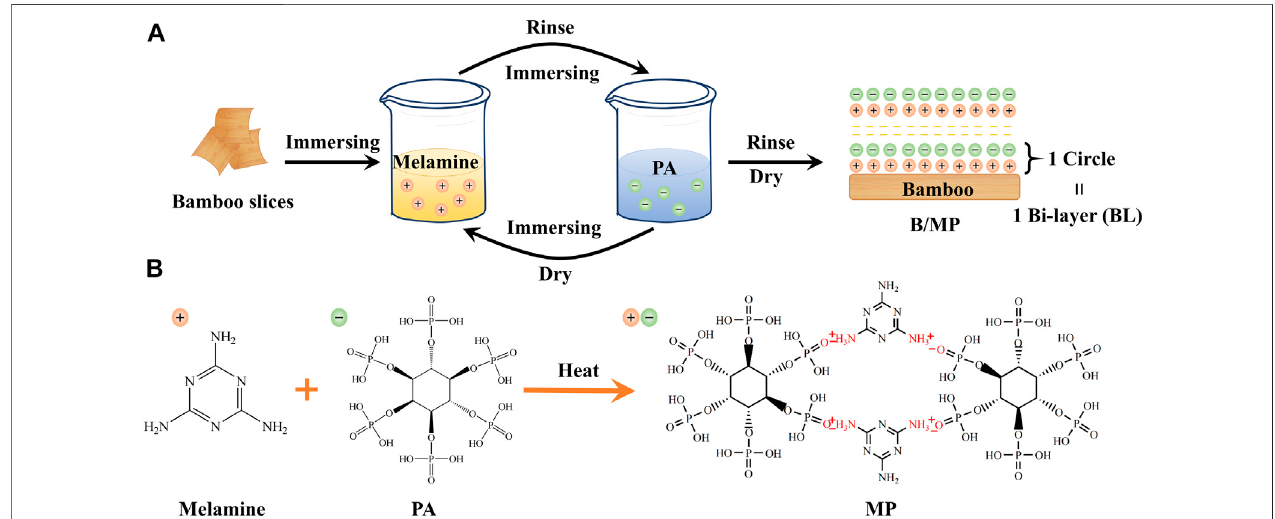
FIGURE 1 | Diagrammatic illustration of LBL treatment of bamboo slices (A) and the synthetic route of MP (B) .